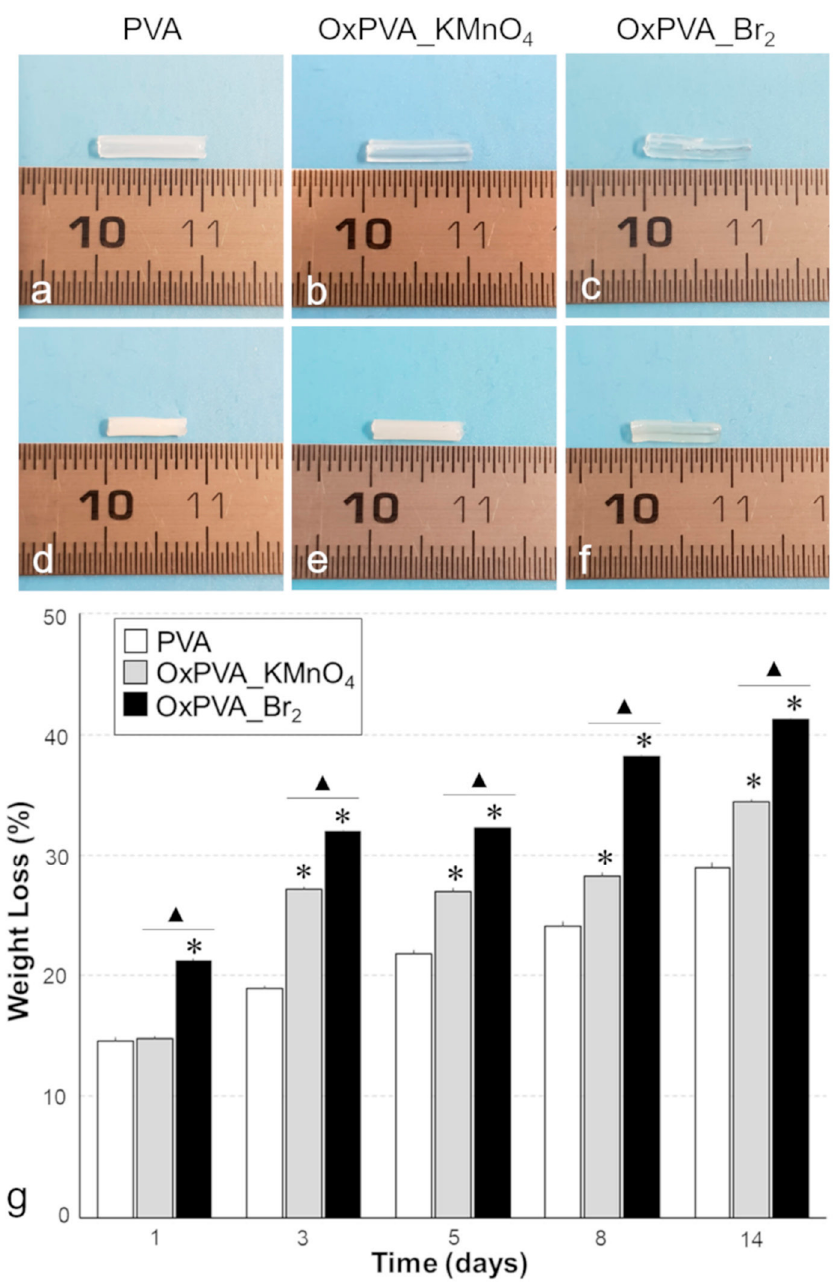
Figure 6. Enzymatic degradation . ( a – f ) Gross appearance of neat and oxidized PVA nerve conduits soon after manufacture ( a , b , c ) and after 14 days of incubation in human plasma + collagenase B solution ( d , e , f ). ( g ) Sample weight loss measured at 1, 3, 5, 8 and 14 days of incubation in enzymatic solution (*: p < 0.01, OxPVA_KMnO 4 or OxPVA_Br 2 vs. PVA; ▲ : p < 0.01, OxPVA_KMnO 4 vs. OxPVA_Br 2